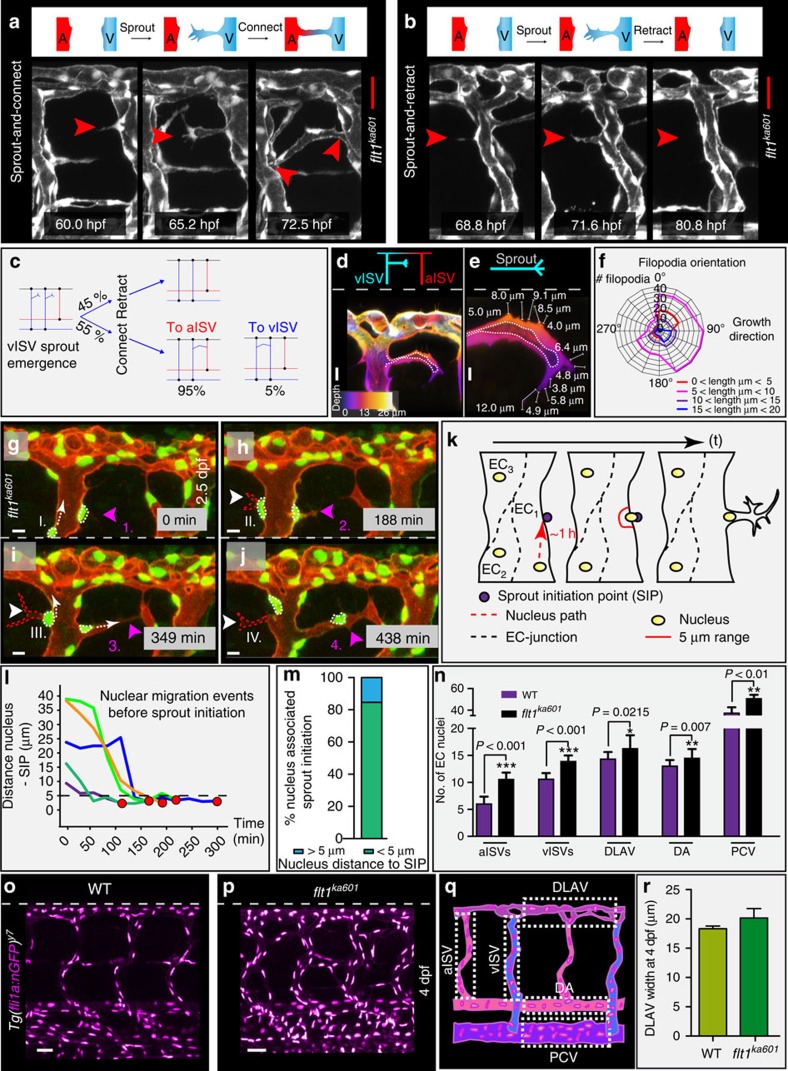
Imaging and quantification of sprouting kinetics in flt1ka601 mutants.(a) Time lapse imaging of sprout initiation and anastomosis formation in flt1ka601 mutant. Sprout initiation (60.0 hpf), elongation (65.2 hpf) and connection-anastomoses (72.5 hpf) with adjacent aISV. (b) Time lapse imaging of sprout initiation and retraction in flt1ka601 mutant. Endothelial cells produce filopodia (68.8 hpf), extend a sprout (71.6 hpf), which subsequently retracts (80.8 hpf). (c) Quantification of data in (a,b) showing % of sprouts retracting (top part, 45%) or connecting (bottom part, 55%) to adjacent ISVs. In the latter scenario sprouts in 95% of cases connected to aISV (red) and in 5% of cases to vISV (blue). Angiogenic behaviour was analysed in time-lapse confocal movies, n=20 embryos. (d–f) Filopodia directionality and length in flt1ka601 mutants (n=10 embryos, n=920 filopodia). (g–j) Time lapse imaging of endothelial nuclei in Tg(fli1a:nGFP)y7; Tg(kdrl:hsa.HRAS-mcherry)s916 showing association between nuclear position and sprouting initiation point (SIP). Note that sprouts arise in close proximity to the position of the nucleus. Arrowheads indicate sprouts; nuclei at indicated time points (sprout initiation with actively migrating nucleus towards SIP I, II, III, IV and nucleus already located at SIP 1,2,3,4). (k) Schematic representation of nuclear position with respect to SIP. (l,m) Quantification of observations in g–j. Red dot indicates sprout initiation time point. Note that sprouting preferentially occurs when endothelial nuclei are within less than 5 μm from SIP (SIP below dotted line in (l)). n=5 (l) and n=13 (m). (n–q) Quantification of EC nuclei in aISV, vISVs, DLAV, DA and PCV of WT and flt1ka601 embryos at 4 dpf; mean±s.e.m., t-test, n=21 embryos per genotype. (r) Quantification of DLAV width in WT and flt1ka601 mutant, n=9 embryos per genotype. A, artery; aISV, arterial intersegmental vessel; DA, dorsal aorta; DLAV, dorsal longitudinal anastomotic vessel; EC, endothelial cell; PCV, posterior cardinal vein; SIP, sprout initiation point; V, vein; vISV, venous intersegmental vessel. Scale bar, 30 μm in a,b; 10 μm in d,e,g–j; 50 μm in o,p.